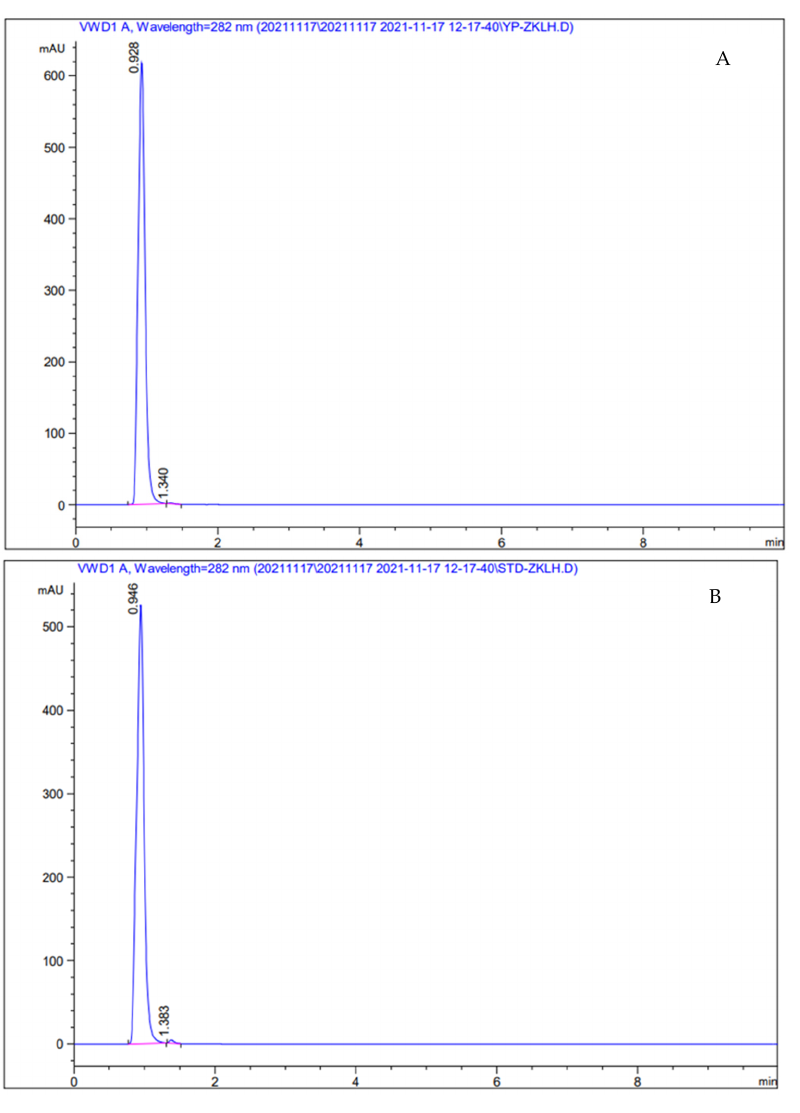
Table 1. Effects of a 28 d high-fat diet on mouse blood lipid levels (x ± SE; n = 5). Groups